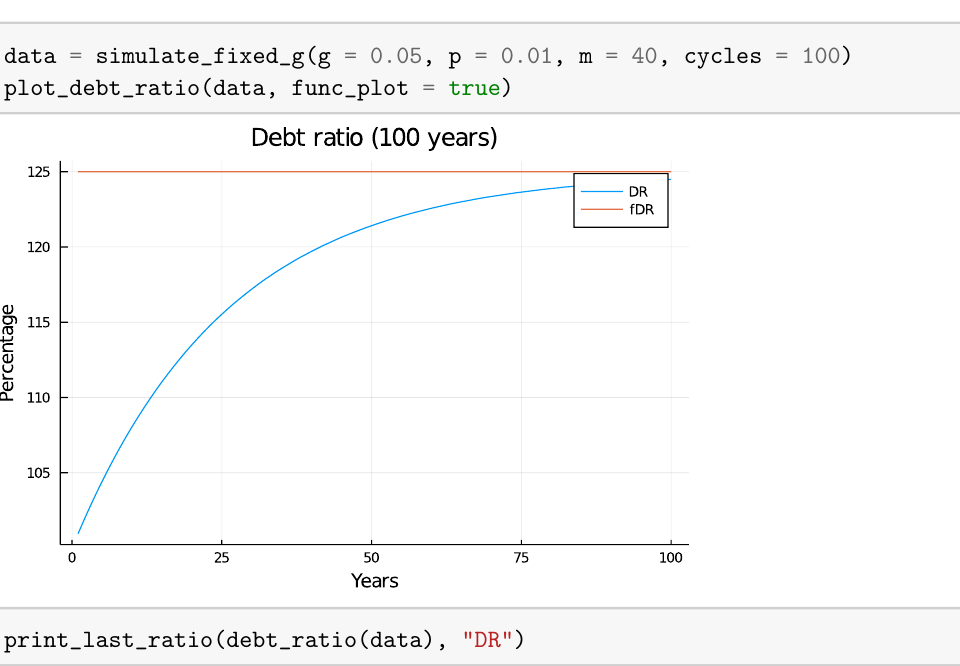
Figure 21. Debt ratio (g = 5%, p = 1%, m = 40 years).